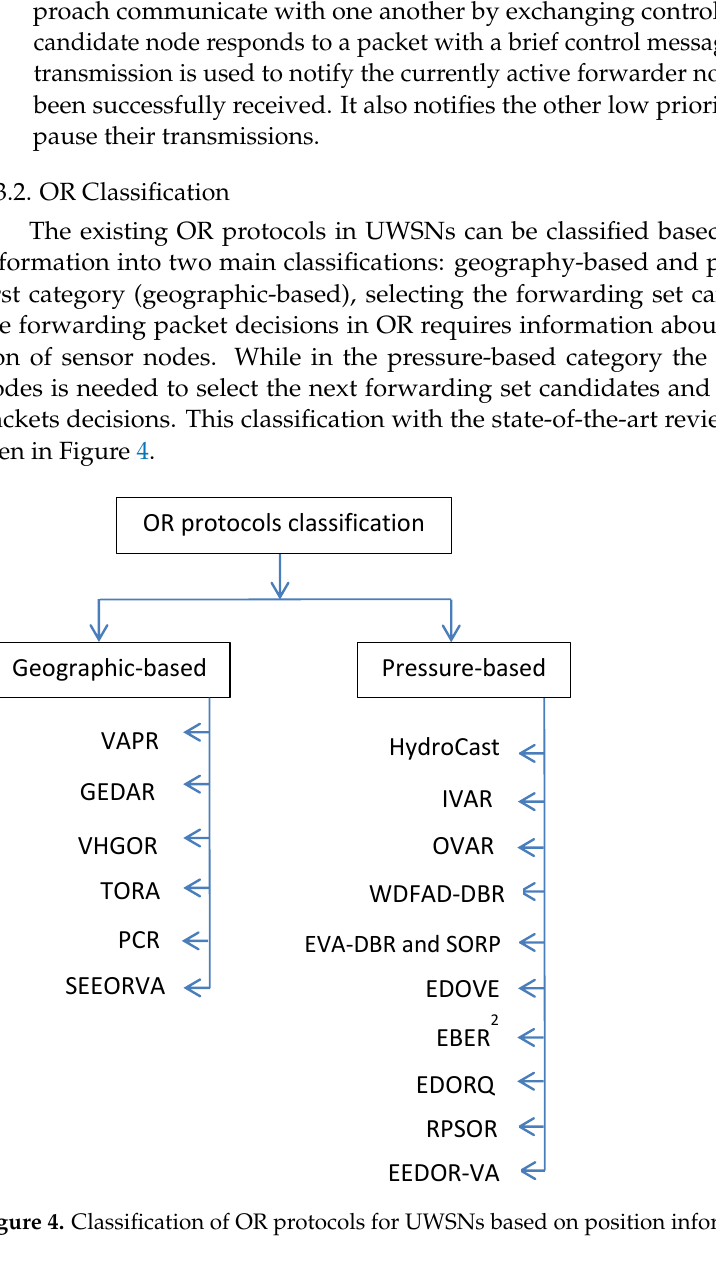
Figure 4. Classification of OR protocols for UWSNs based on position information.